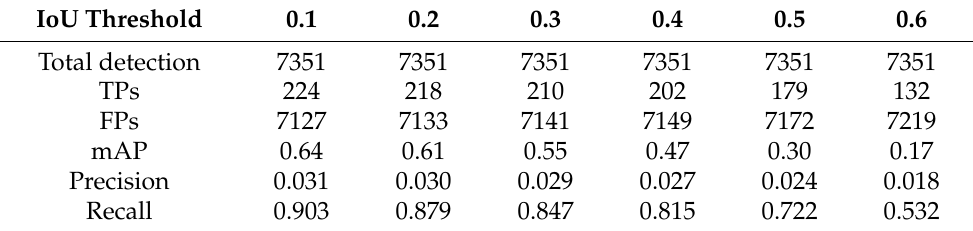
Table 4. Customized RetinaNet Test results (using Epoch 3 trained weights, actual positives: 248). GPU configuration: same as Table 3. Total inference time of 183 images: 24.70